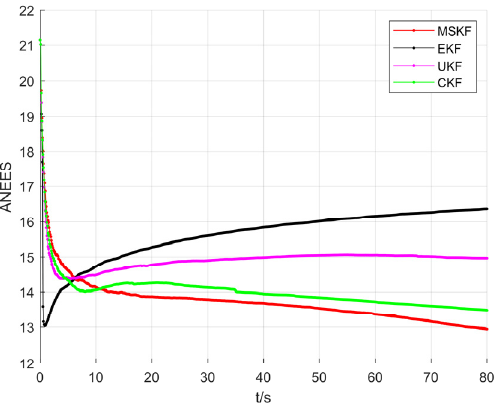
Figure 11. Comparison of ANEES of CL distribution.